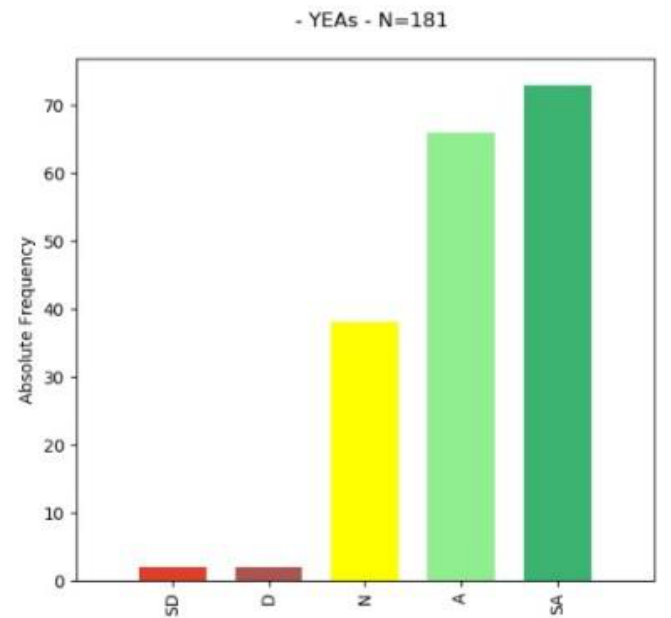
Fig. 7. STEP and YAEs recommending the platform to